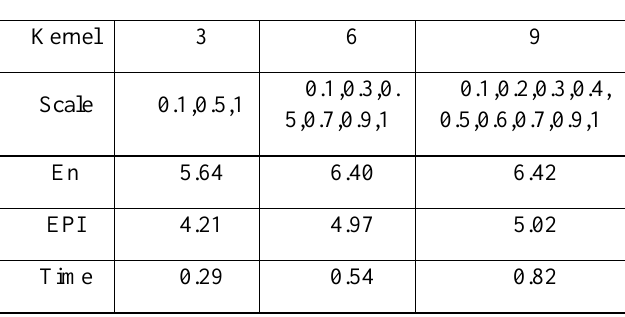
Table 1. Running time of MSC with different parameters and En, EPI of images processed